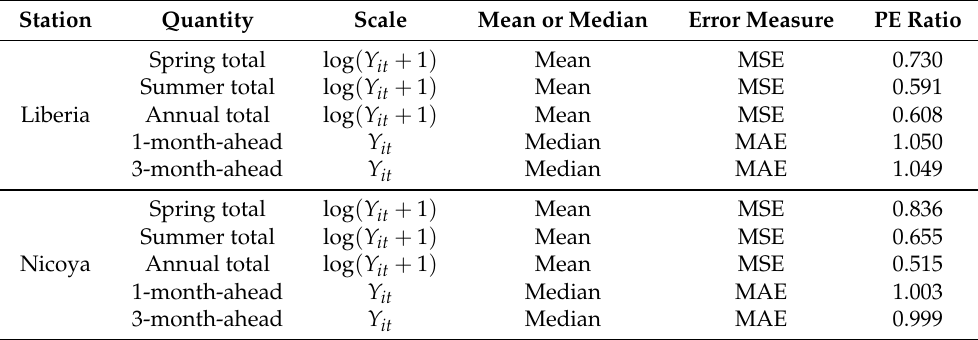
Table 4. Ratio of the prediction error (PE) based on the double-Gaussian model (where ONI is assumed known) to that based on the naive method (sample means/medians by